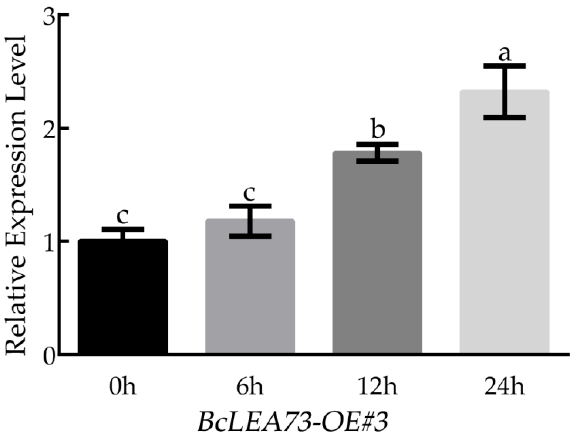
Figure 15. Relative expression level of BcLEA73-OE#3 under low-temperature treatment. Bars with different letters “a, b, c” above the columns indicate significant differences ( p < 0.05, Duncan’s range test) on a given day of treatment. Relative gene expression levels were calculated using the 2 − ∆∆ CT method.